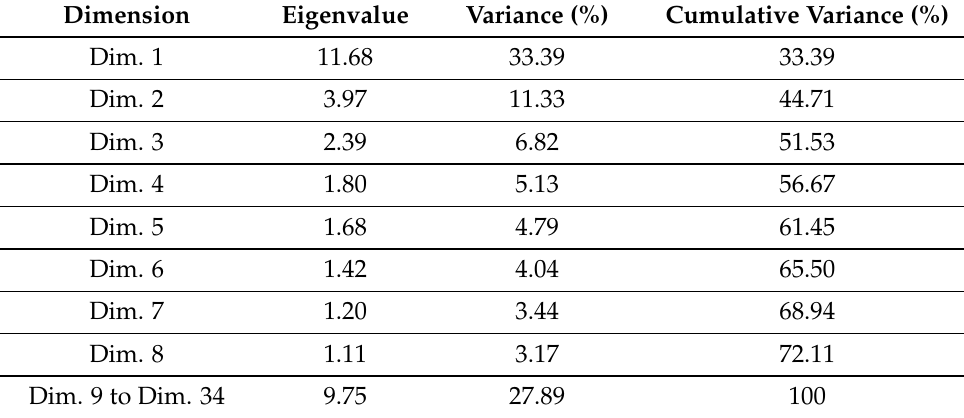
Table 6. PCA results—variance accounting for individual components. Dimension Eigenvalue Variance (%) Cumulative Variance